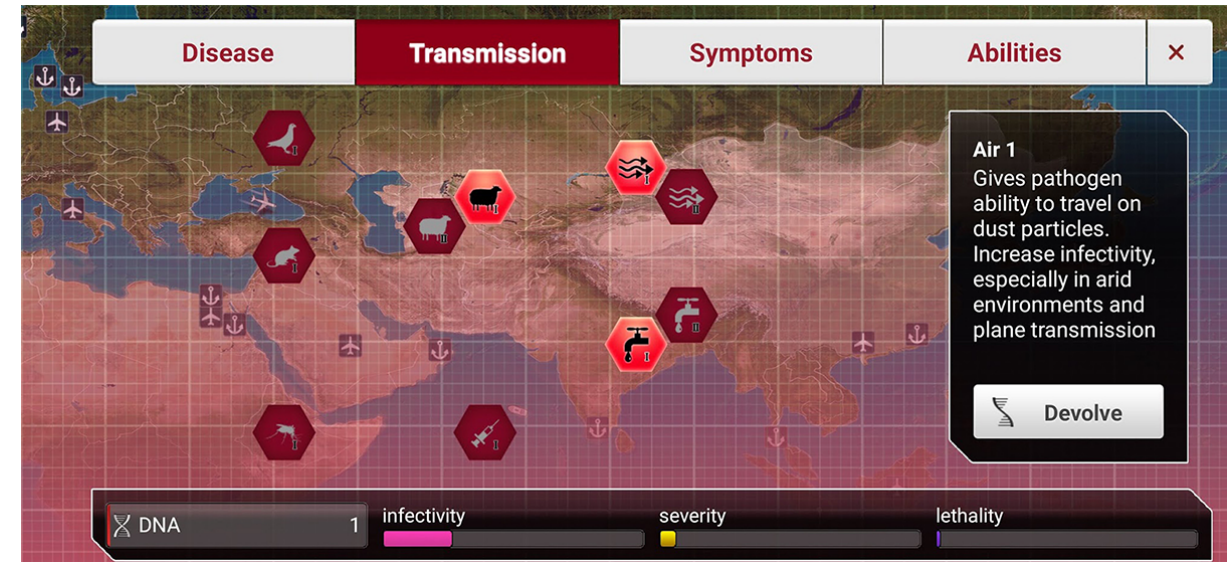
Figure 3. Screenshot of Plague Inc.: disease